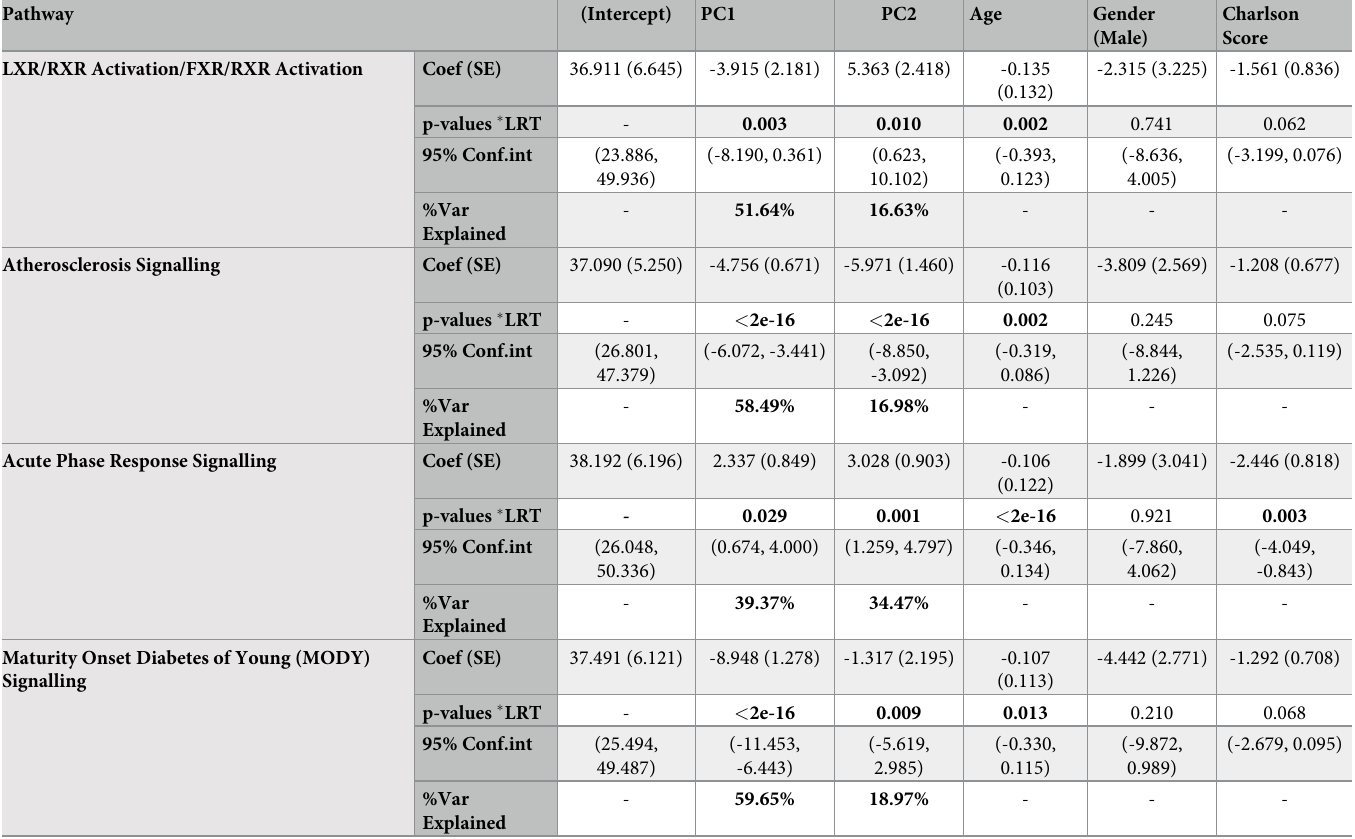
Summary of multivariate linear regression models with COVID-19 severity as the outcome using patients with COVID-19 only, and the principal components used to summarize the enriched pathways associated with disease severity status as the predictors. The models are also adjusted for the clinical covariates age, sex and Charlson comorbidity score. P-values for significance are determined via the likelihood ratio test